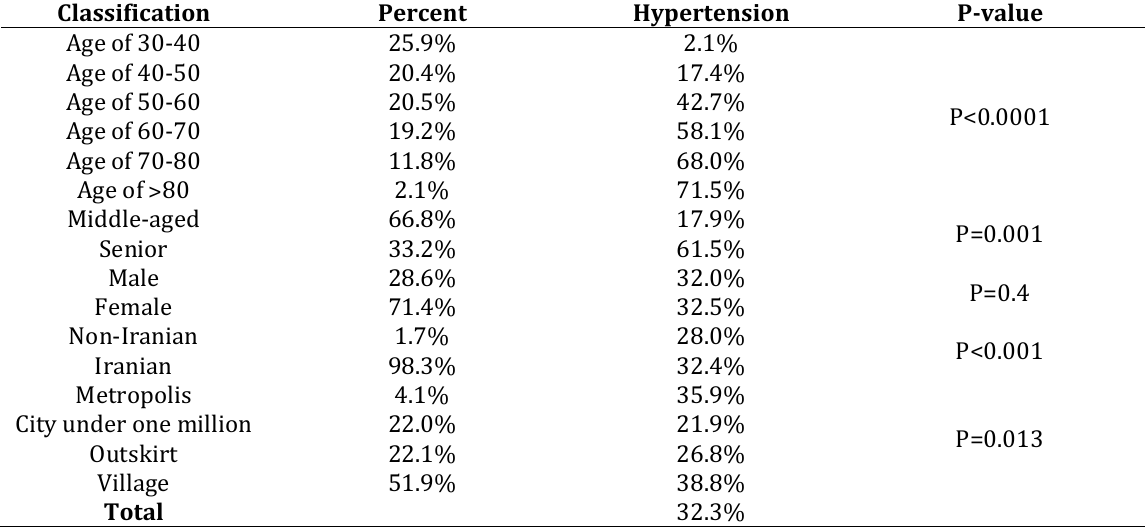
Table 3: Demographic characteristics of the participant Classification